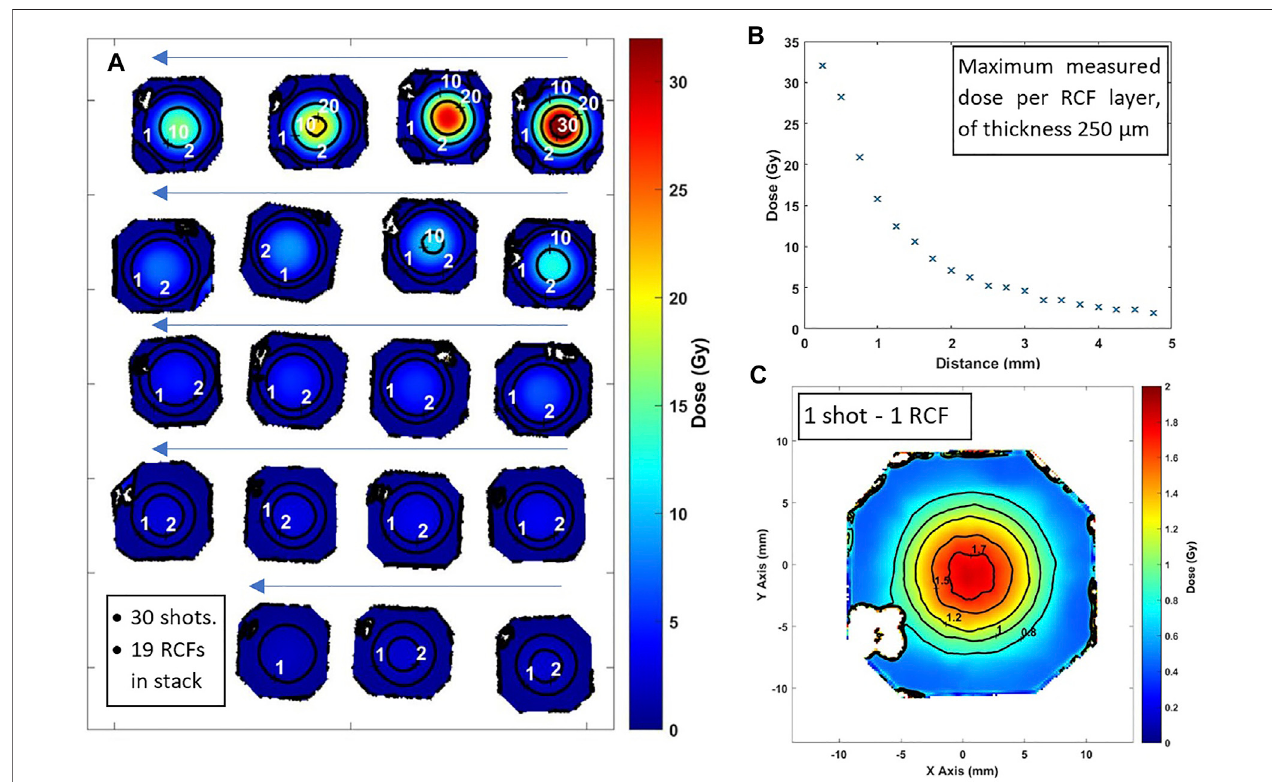
FIGURE7 | (A) A series of19 scanned RCF images in the order (starting from right-top) they are placed inthe stack,irradiated by 30 electron shots. Iso-doselines are shown. (B) Maximum dose measurement on the RCF fi lm as a function of the penetration range in the stack. (C) Scanned image ofa single RCF after irradiated by a single